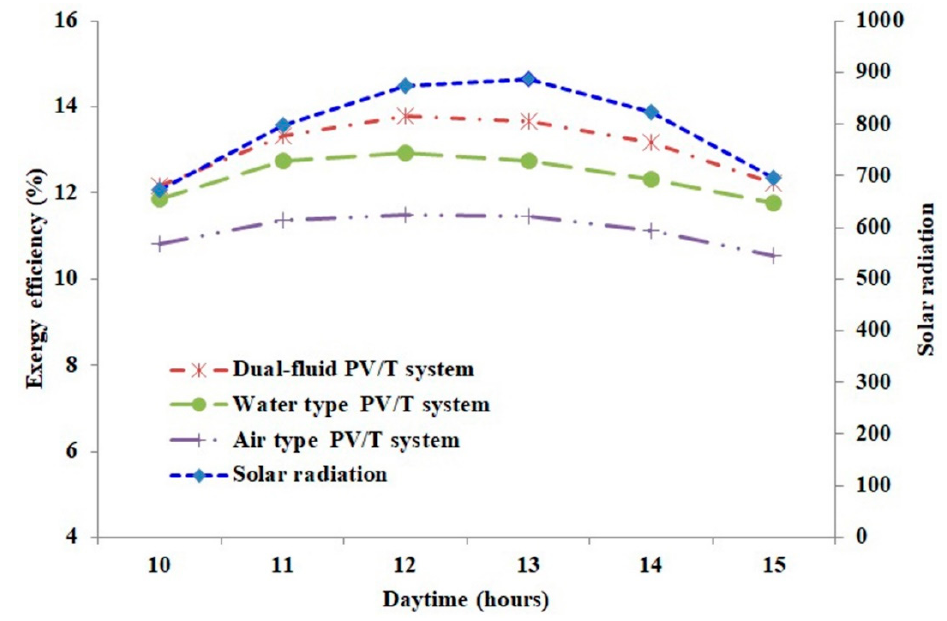
Figure 8. Daily exergy efficiency of the PV/T systems plotted against different fluid operations.